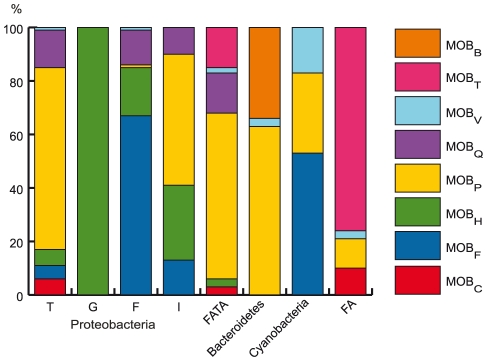
Distribution of the different MOB families among clades.(See also Figure 6.) The figure shows the percentage of each MOB type (color code at the right) associated to each MPF type.